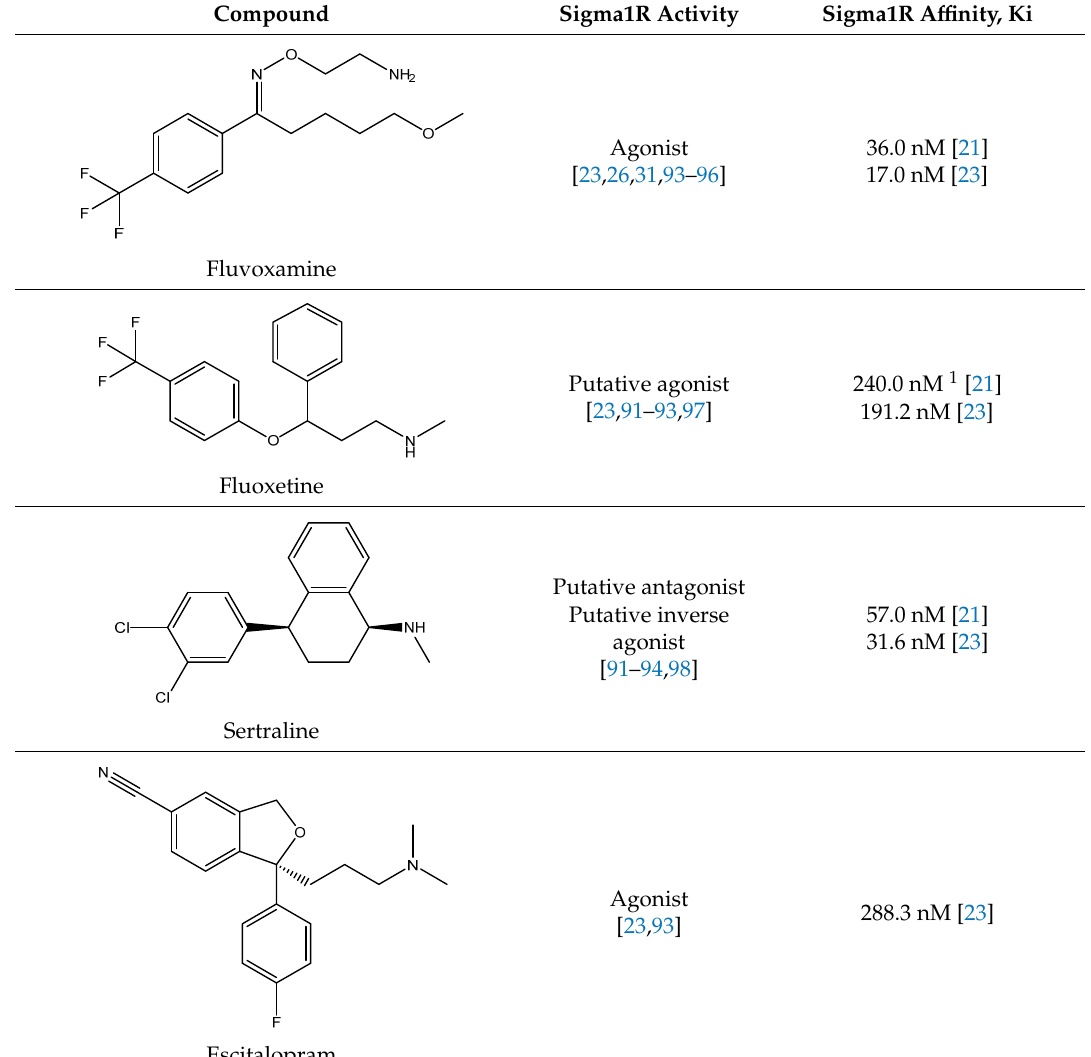
Table 1. Sigma1R ligand with antidepressant properties.